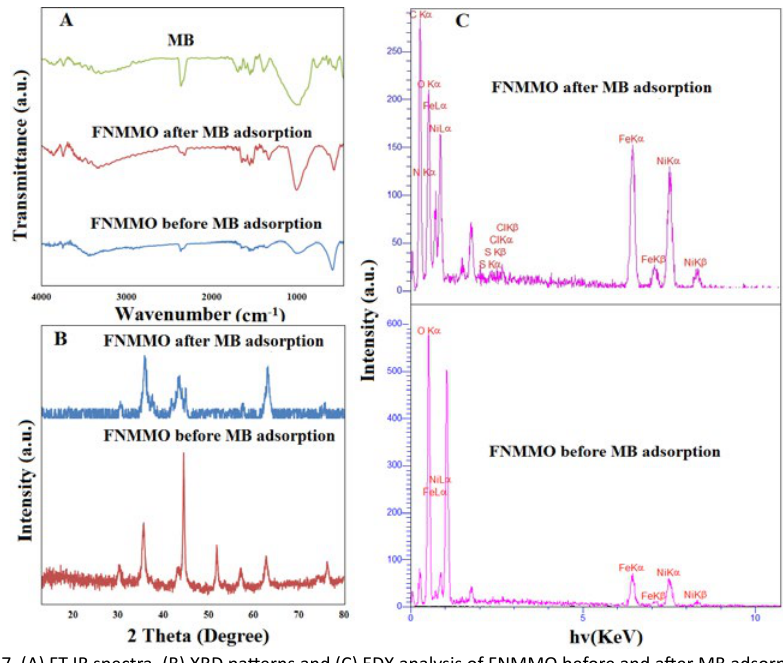
O /NiO at various of pH, (B) adsorption of MB onto Fe 3 4 O /NiO at different concentrtiaon of dye and (D) Study of MB adsorption 3 4 onto Fe O /NiO at various 3 4